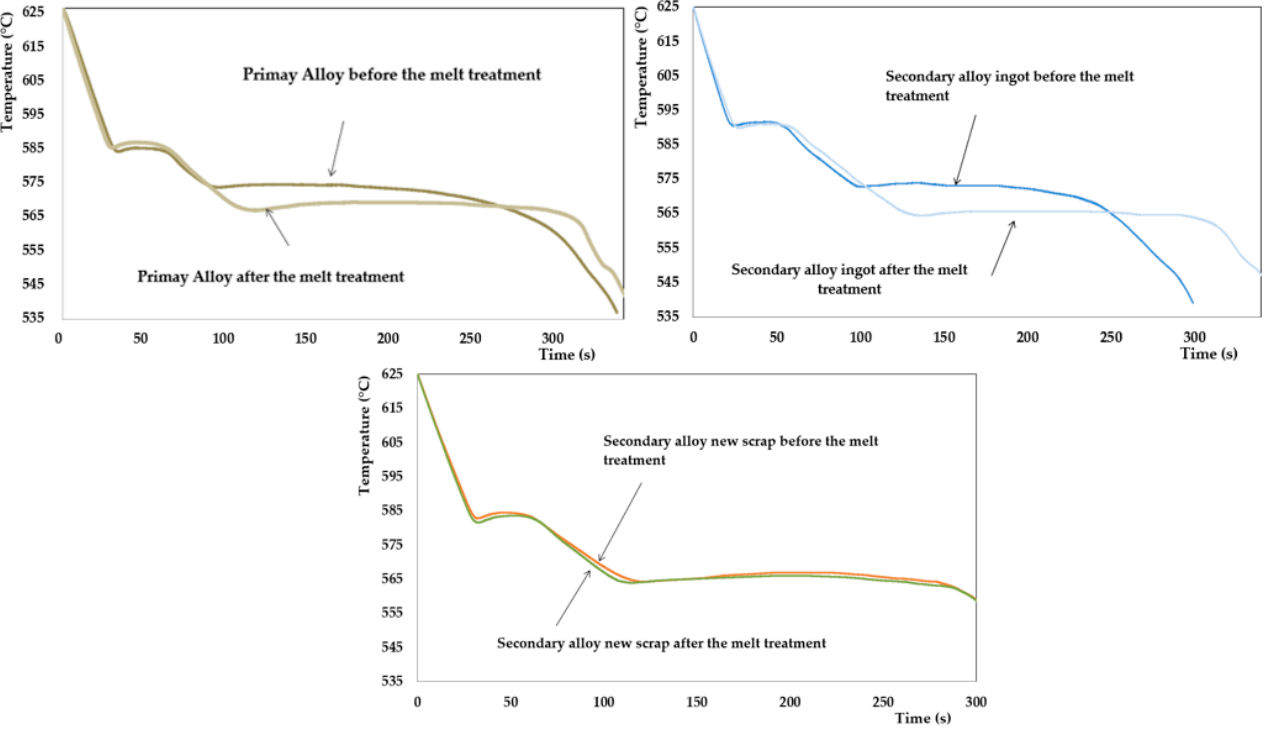
Figure 4. The cooling curves for the different alloys before and after the melt treatment. Table 2. The main cooling curve parameters and modification rate predictions for Themolan ® -Al for V-HPDC AlSi10MnMg